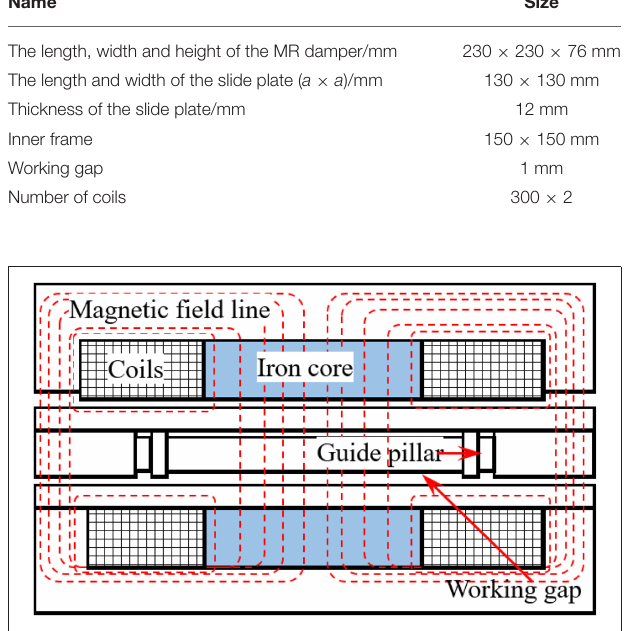
FIGURE 2 | Diagram of bipolar magnetic circuit structure.